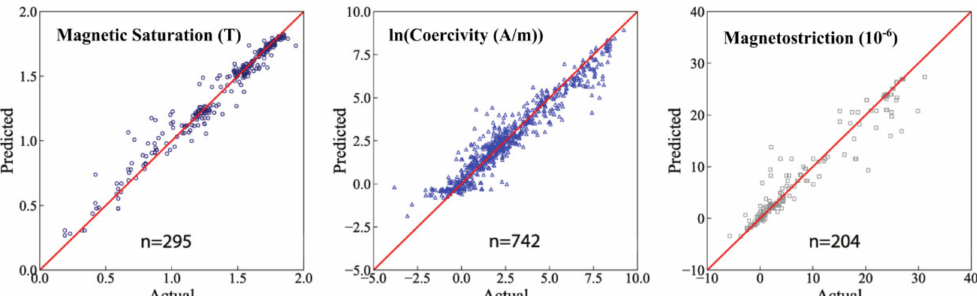
Figure 3. Experimental versus predicted (via machine learning) values of magnetic saturation (polarization), coercivity, and magnetostriction for Finemet-type soft magnetic alloys. Further information available in [19]. Reprinted with permission from Elsevier.